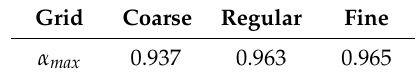
Figure 2. Velocity along the centerline on the symmetry plane under different grids. Table 1. Maximum vapor volume fraction under the different